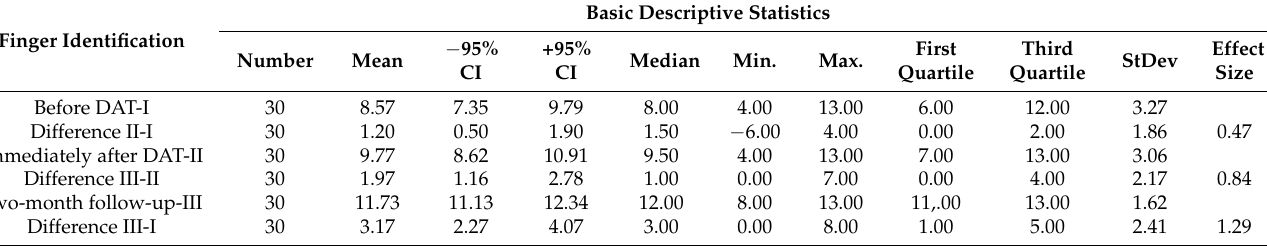
Table 2. Identification—analyses of the measurements performed over time.